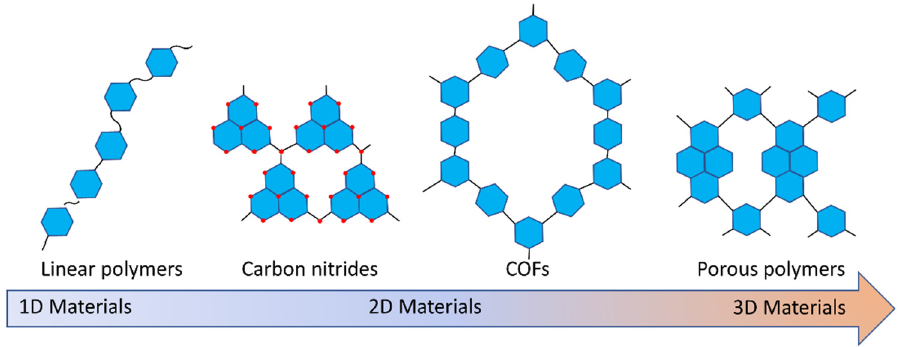
Figure 1. Classes of organic photocatalysts for solar fuels production.